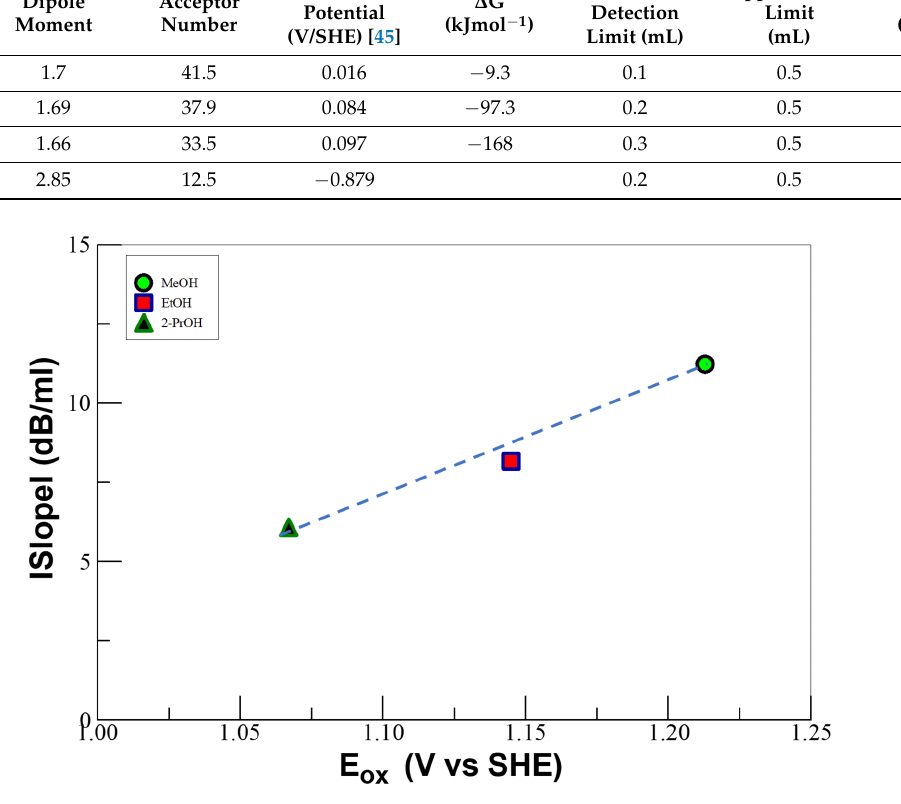
Figure 6. The dependence of the slope of the analyte volume dependence of insertion loss on the electrocatalytic oxidation potential of aliphatic alcohol analytes on a platinum-based catalyst, taken from Lammy et al. [45]. The blue dashed line is just a visual aid. Table 1. Summary of |S 21 |-concentration plot features, and some salient physico-chemical proper- ties of neat analytes.